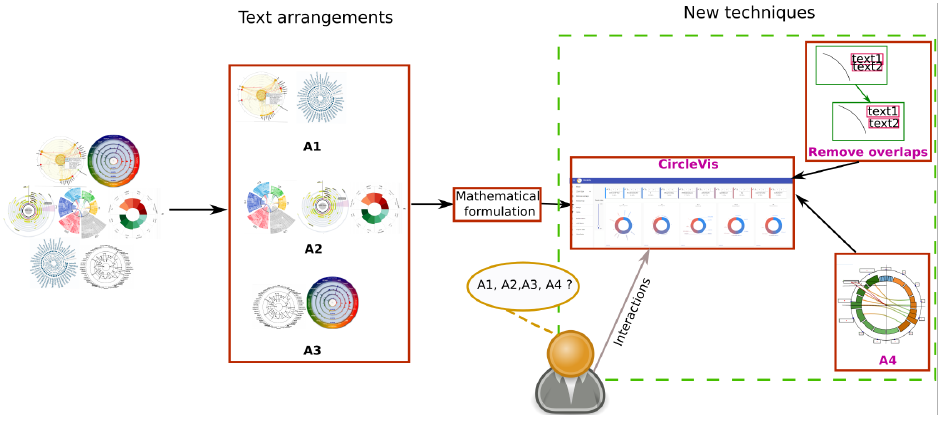
Figure 1. Study workflow and contribution.